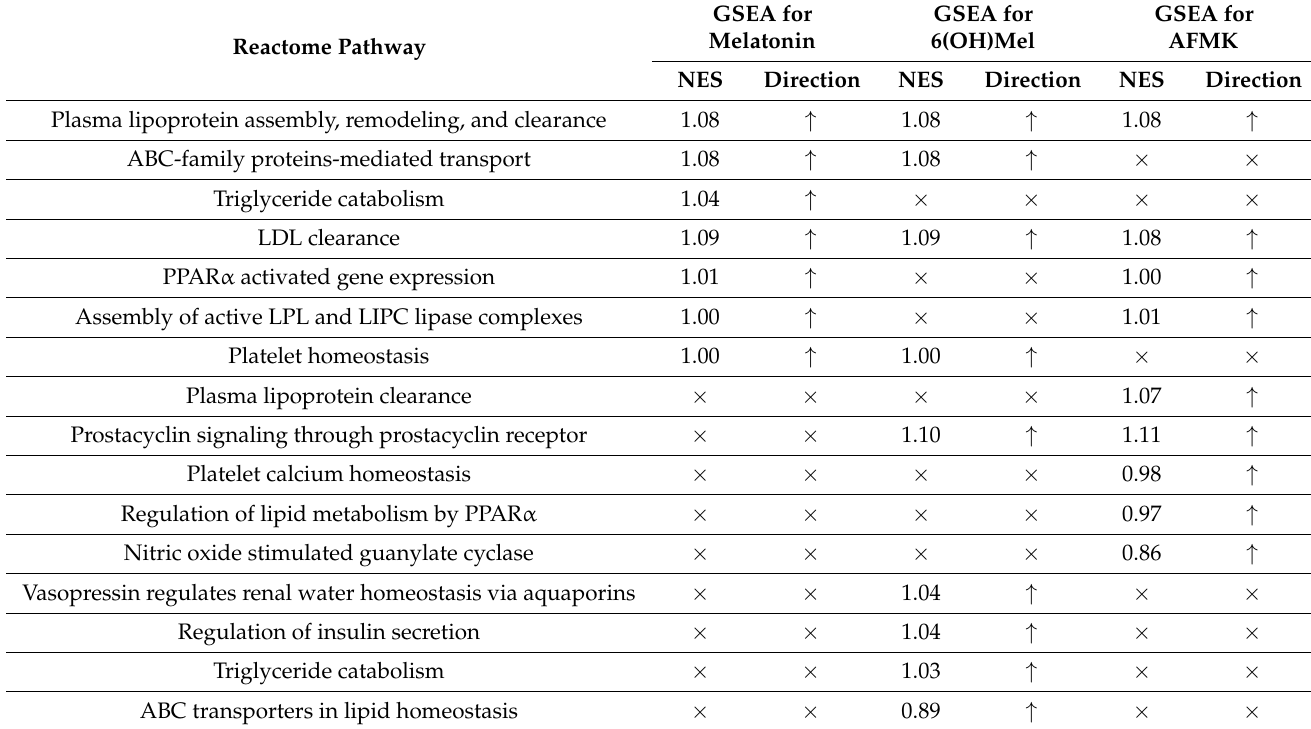
Table 5. Implications for cardiovascular system based on the GSEA of gene expression pattern affected by melatonin, AFMK and 6(OH)Mel in primary human epidermal keratinocytes. NES—normalized enriched score; ( × )—the effect is absent.